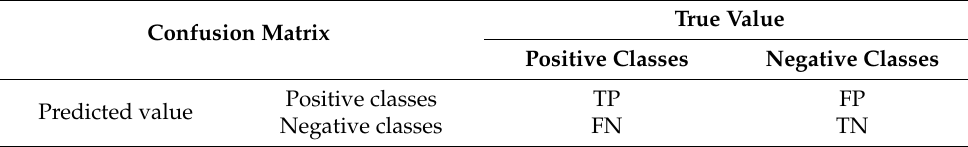
Table 3. Binary confusion matrix.